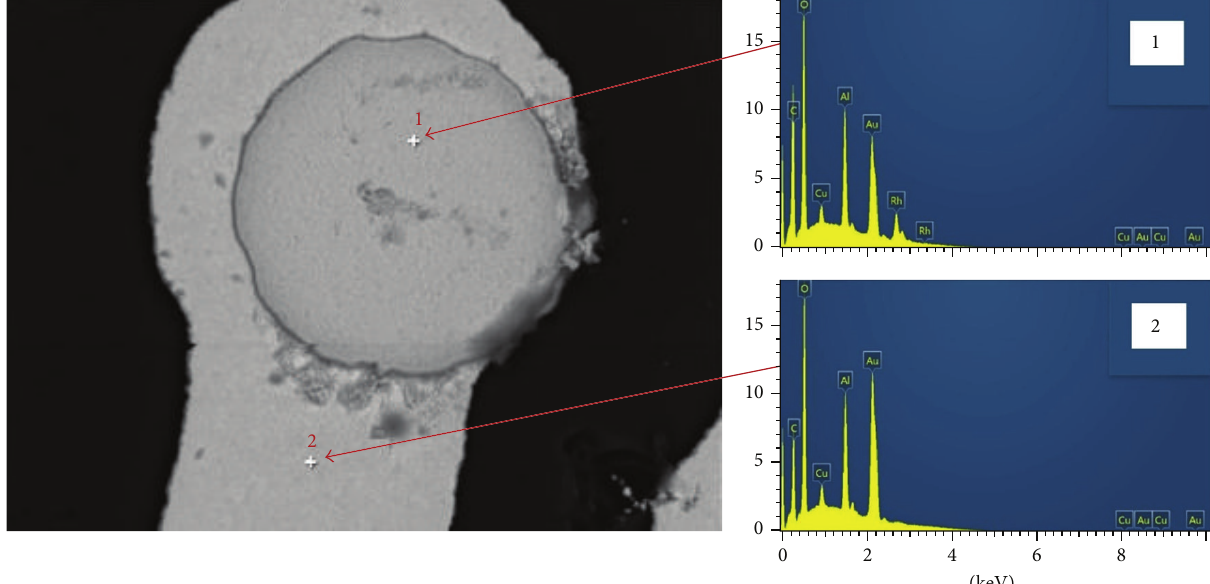
Figure2:SEMimage( × 2200)andEDXanalysisofthefixedbaseofDSswitch.Theelementalcomposition(wt.%)inpoint(1)onthecontacting surface (marked in Figure 1(b) by #3) is Au 52.6, Rh 24.5, O 12.3, Al 8.4, and Cu 2.2, and in point (2) on the conducting path-Au 77.9, O 11.4, Al 8.4, and Cu